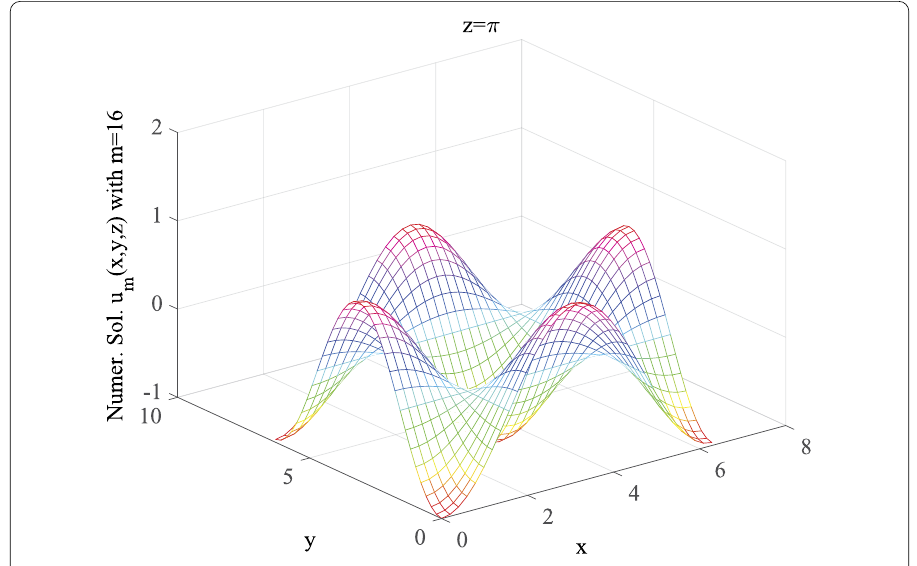
Figure 1 The approximate solution u ( x , y , π ) with m = 16 for Example 6.3